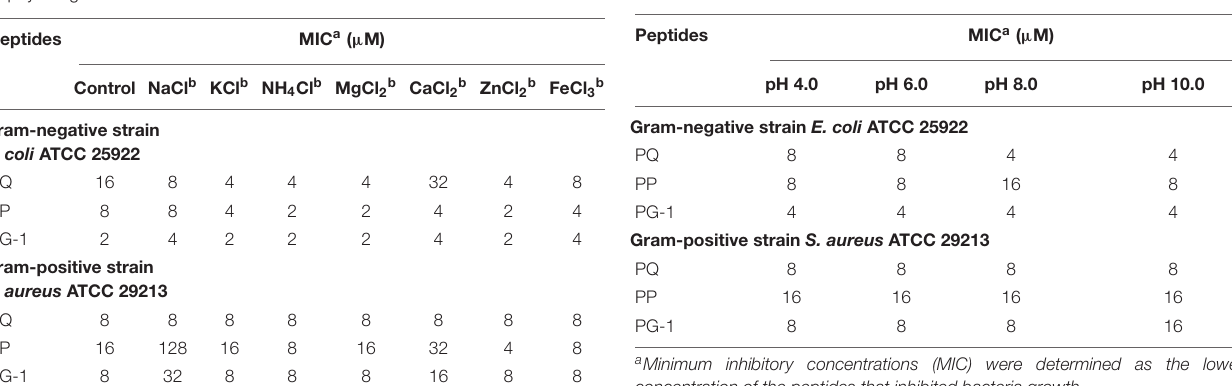
TABLE 6 | Minimum inhibitory concentrations values of peptides in different pH